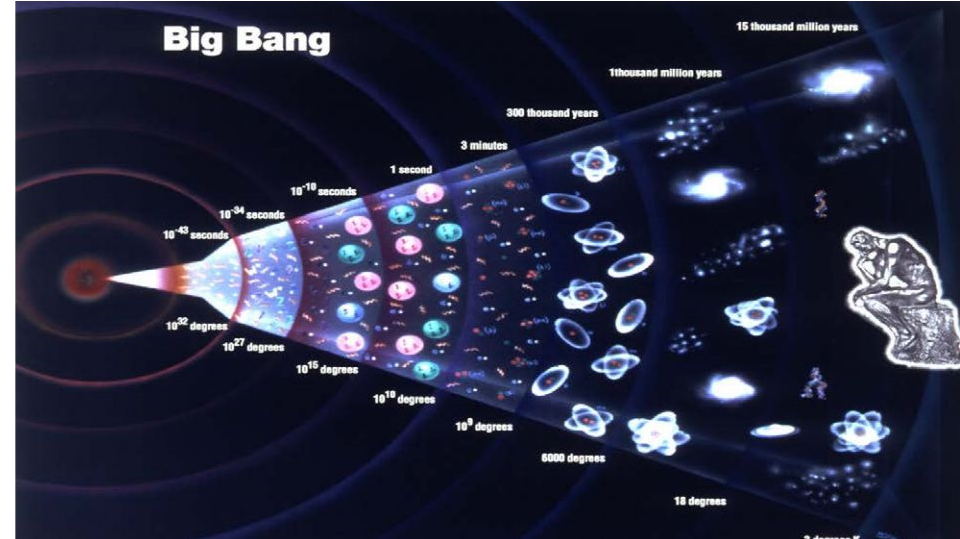
Figure 2. Schematic representation of the Big Bang singularity and subsequent universe evolution. Credit: grandunificationtheory.com.